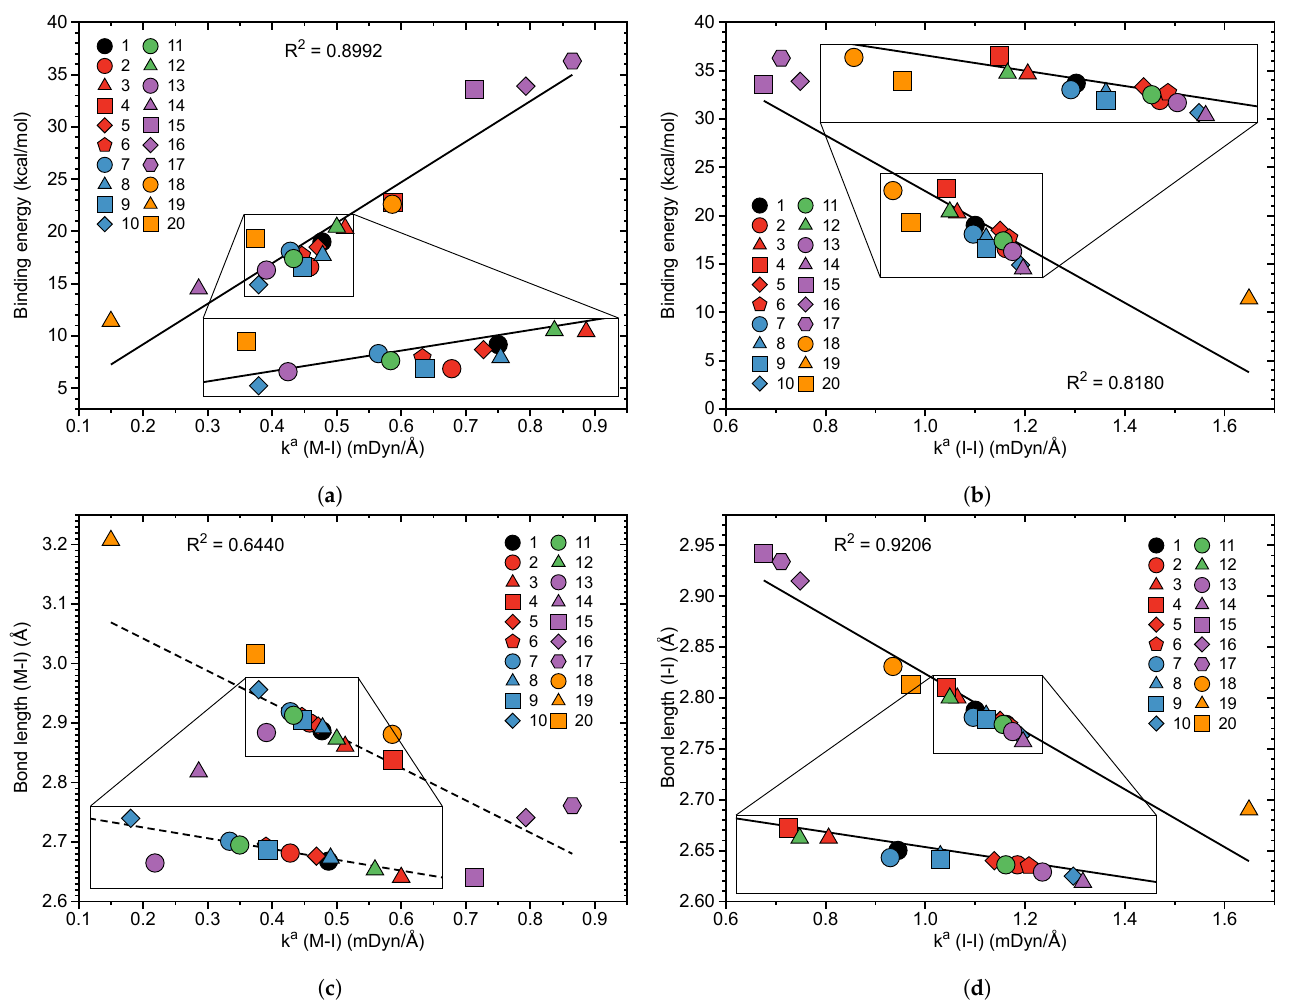
Figure 4. ( a ) Correlation between binding energy ∆ E and local stretching force constant k a of the M − I bonds; ( b ) Correlation between binding energy ∆ E and local stretching force constant k a of the I − I bonds; ( c ) Bond length r versus local stretching force constant k a for the M − I bonds; ( d ) Bond length r versus local stretching force constant k a for the I − I bonds of molecules 1 – 20 . PBE0–D3(BJ)/aug–cc–pVTZ/PP(M,I) level of